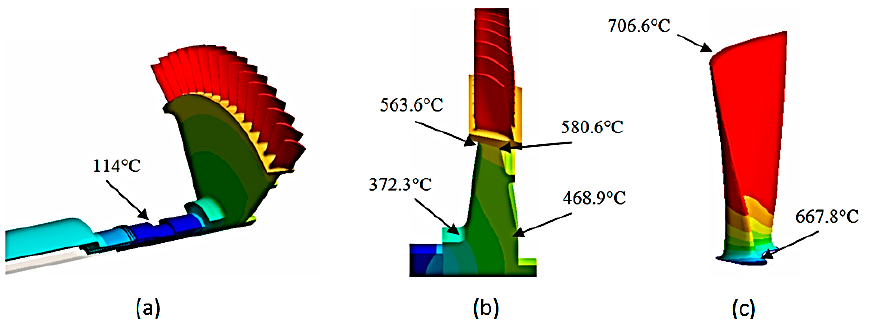
Figure 9. ( a ) Temperature distribution over the turbine disc; ( b ) temperature distribution along the disc profile; ( c ) temperature distribution over a single turbine blade.